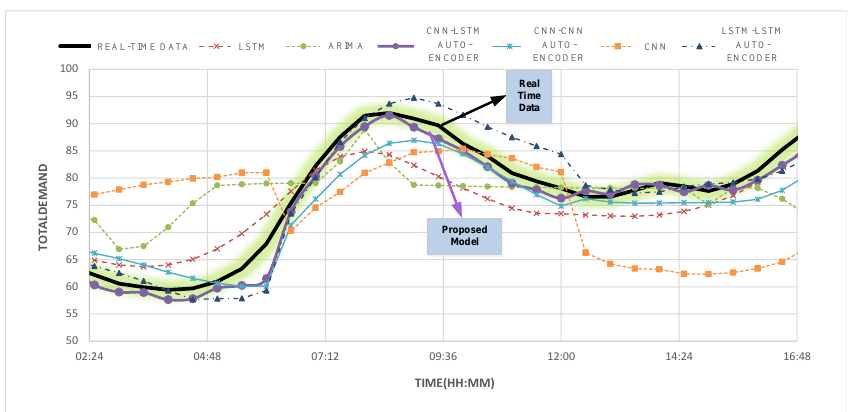
Figure 11. The performance of different models in a time period.